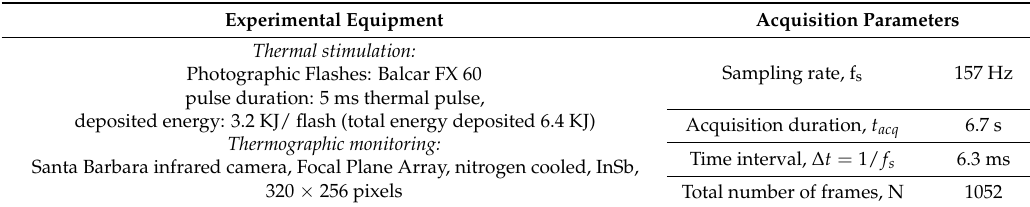
Table 1. Experimental equipment and acquisition parameters.